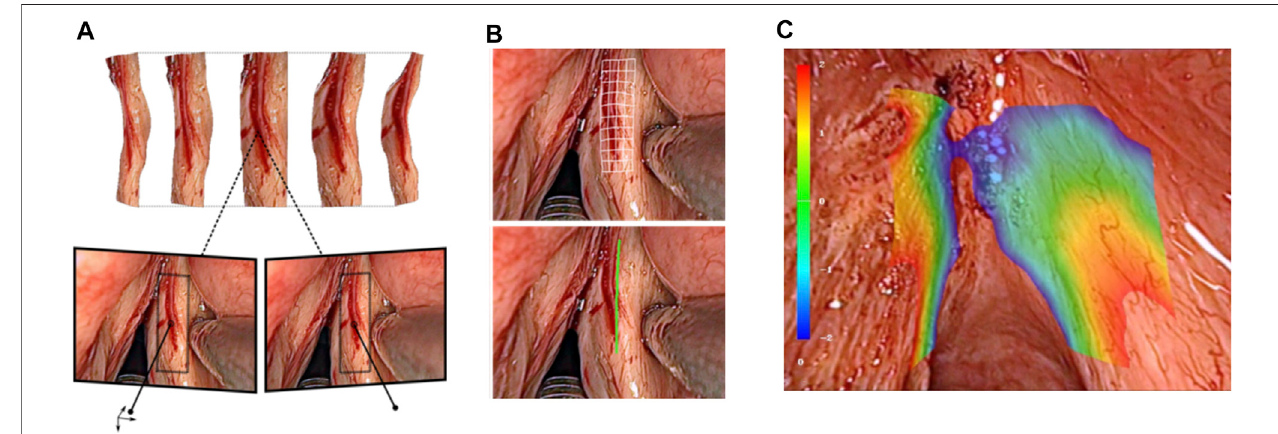
FIGURE 12 | Real-time stereoscopic methods for (A) 3D reconstruction (Schoob et al., 2015). (B) intraoperative incision planning and visualization (Schoob et al., 2017), and (C) laser focus adjustment (Schoob et al., 2016).